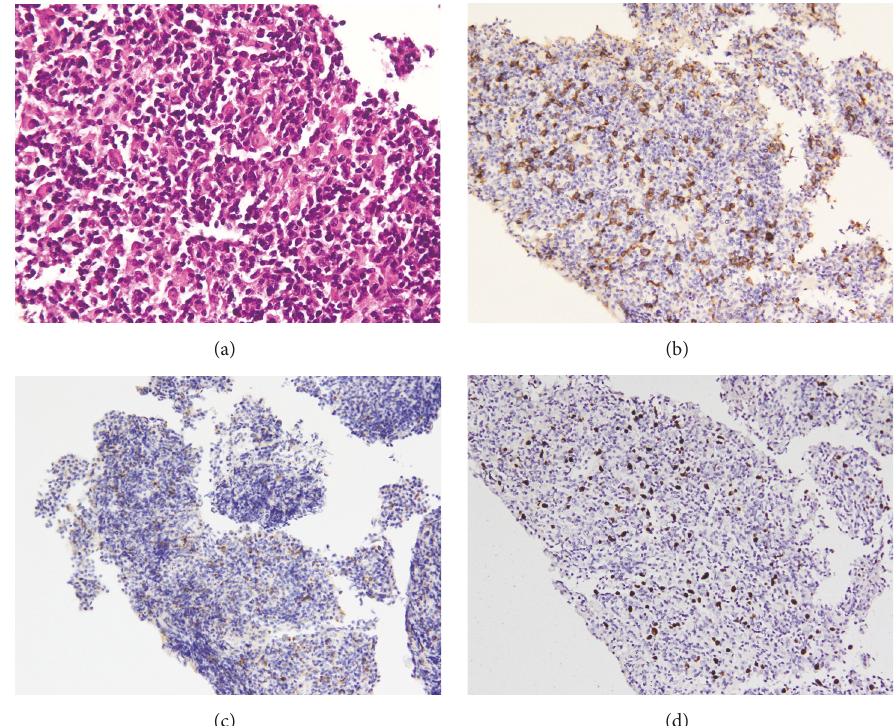
Figure 4: Cell block preparation from the residual FNAC specimen. (a) Neoplastic lymphoid cells with nuclear irregularity (H&E stain, 400x). Immunocytochemical analysis shows lymphoma cells positive for CD56 (b) and granzyme B (c). Nuclei are positive for EBER by in situ hybridization (d)